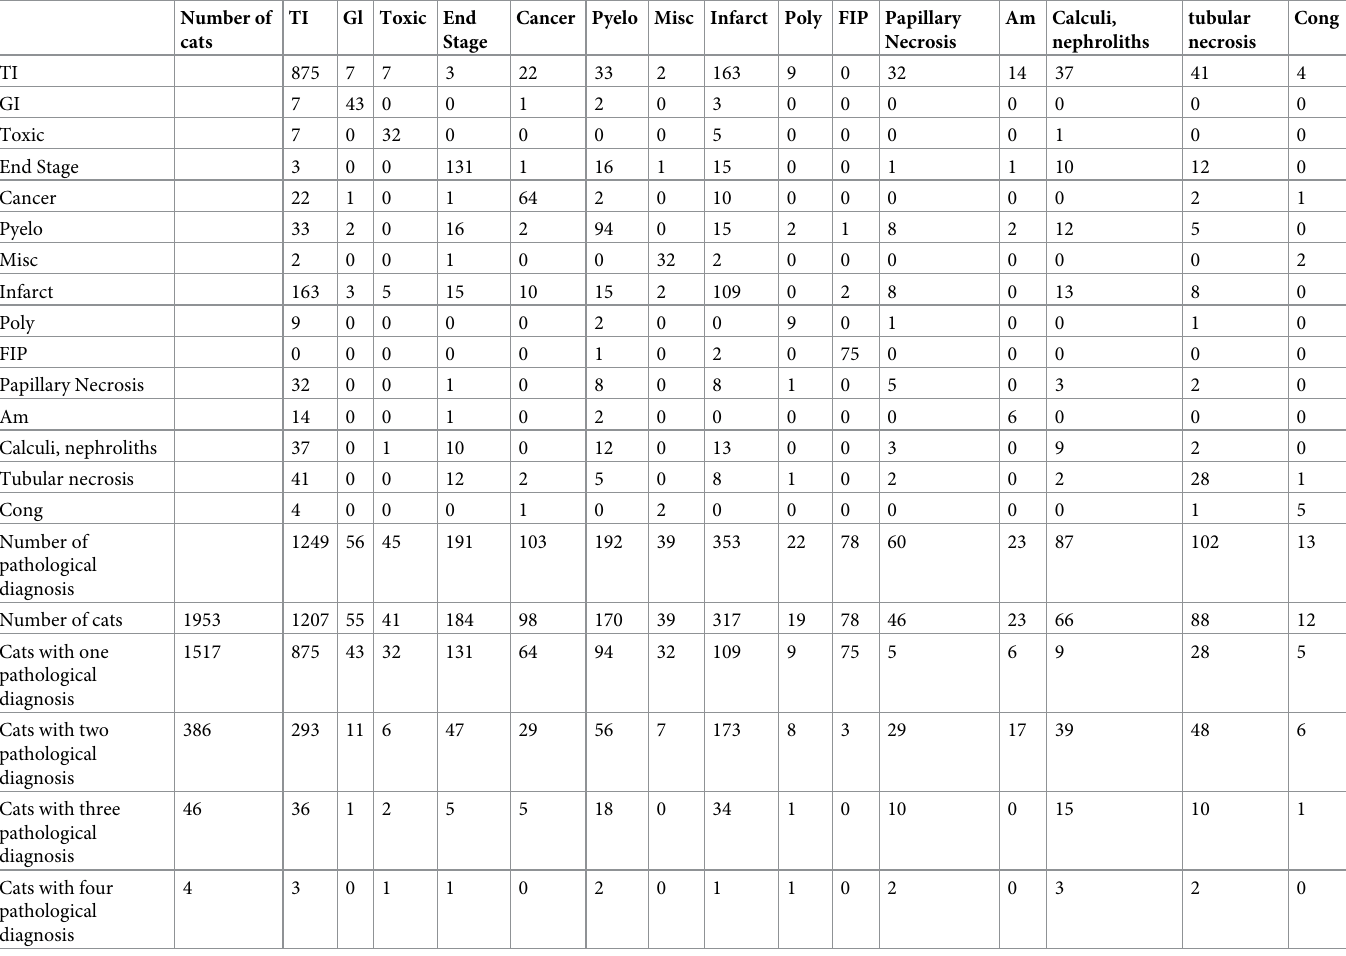
Table 4. Renal disease processes as determined on necropsy examination in cats.